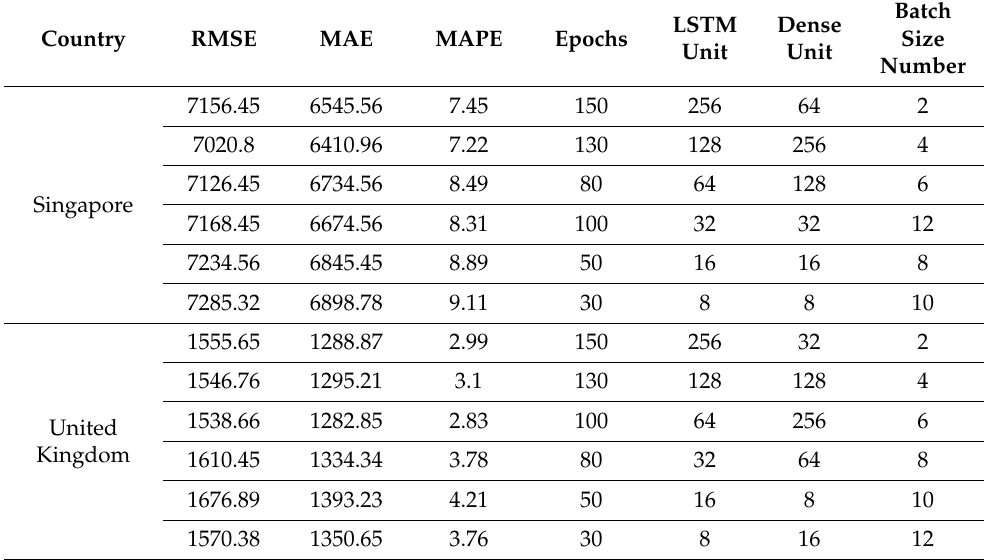
Table 2. Hyper-parameter list of the BiLSTM method used in the sensitivity analysis.